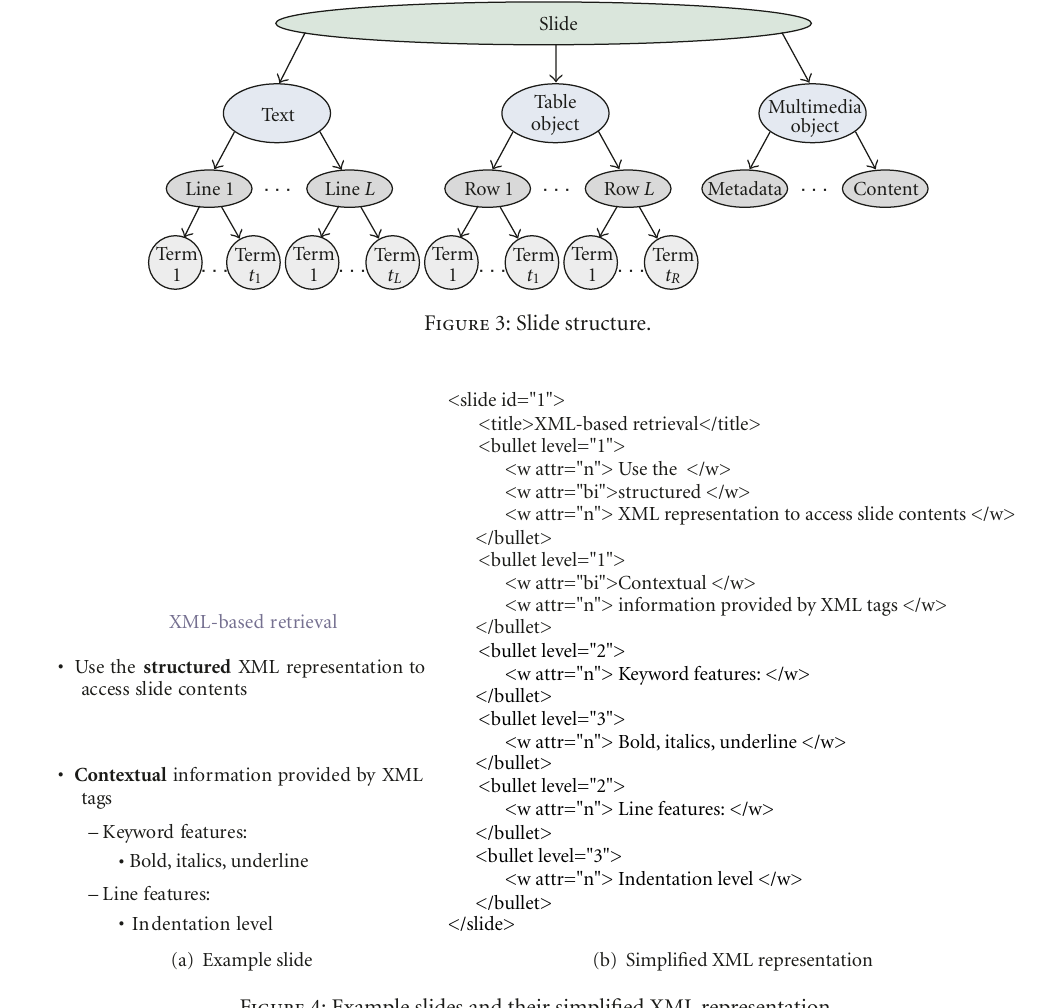
Figure 4: Example slides and their simplified XML